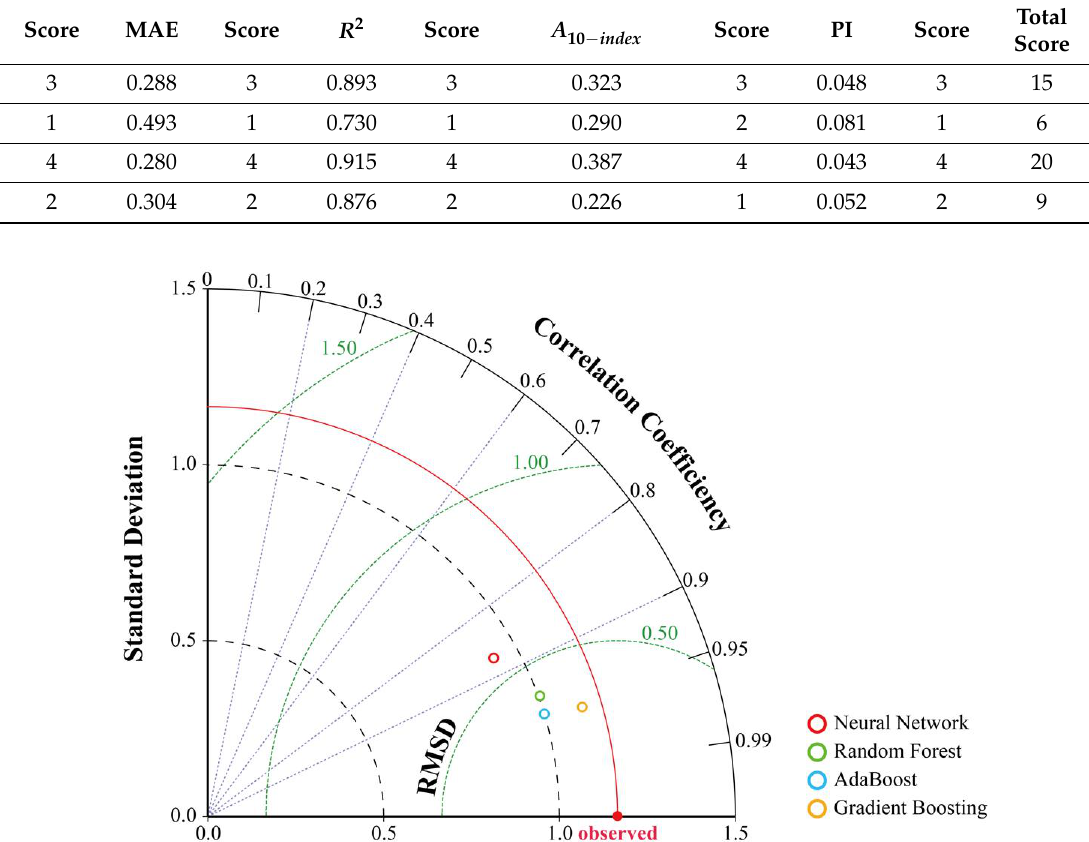
Figure 15 . Taylor diagram of ML model developed. Figure 15. Taylor diagram of ML model